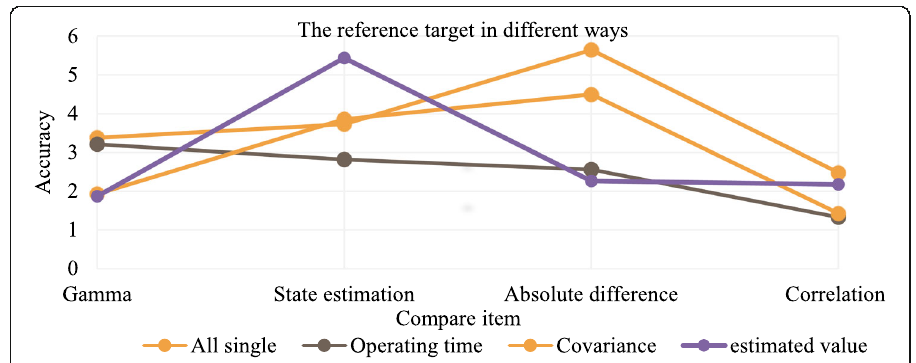
Fig. 6 The reference target in different